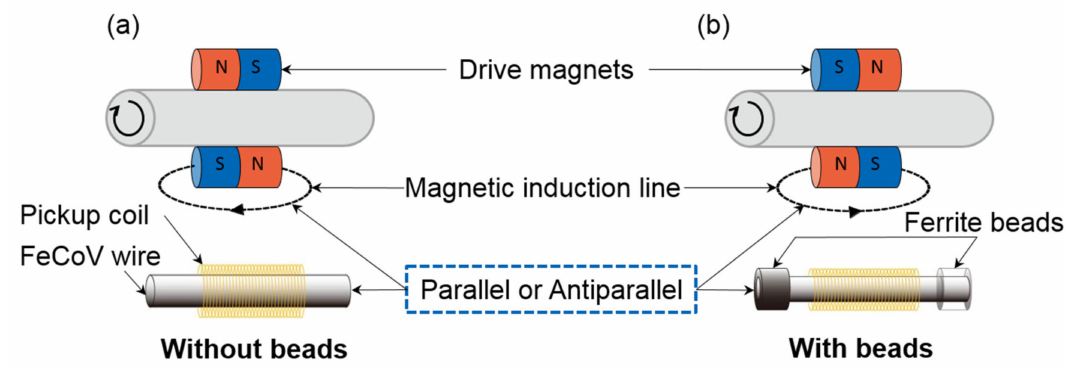
Figure 4. Experimental models: ( a ) “Without beads” model and ( b ) “With beads” model.